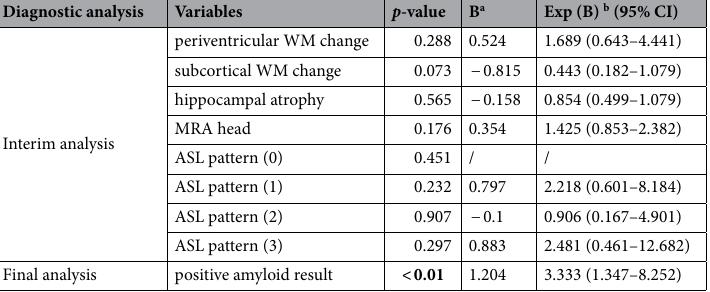
Table 8. Binary logistic regression in the association between neuroimaging variables and diagnostic change. Significant values are in [bold]. a B is logistic regression coefficient. b Exp (B), or the odds ratio, refers to the exponential value of B illustrating the predicted change in odds for a unit increase in the